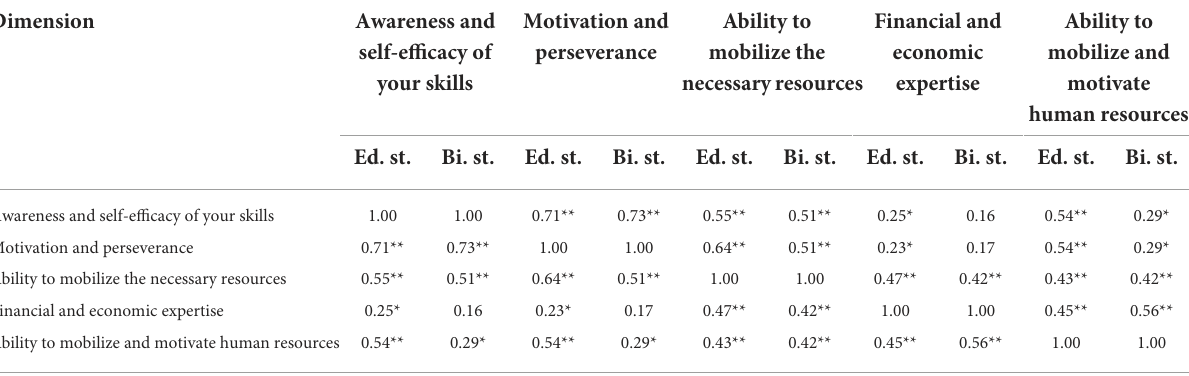
TABLE 7 Spearman’s rank correlation between all dimensions of the identification, and efficient use of internal and external resources sub-competence. Dimension Awareness and